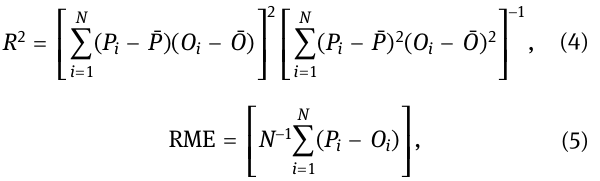
Table 1: Statistical values of the input